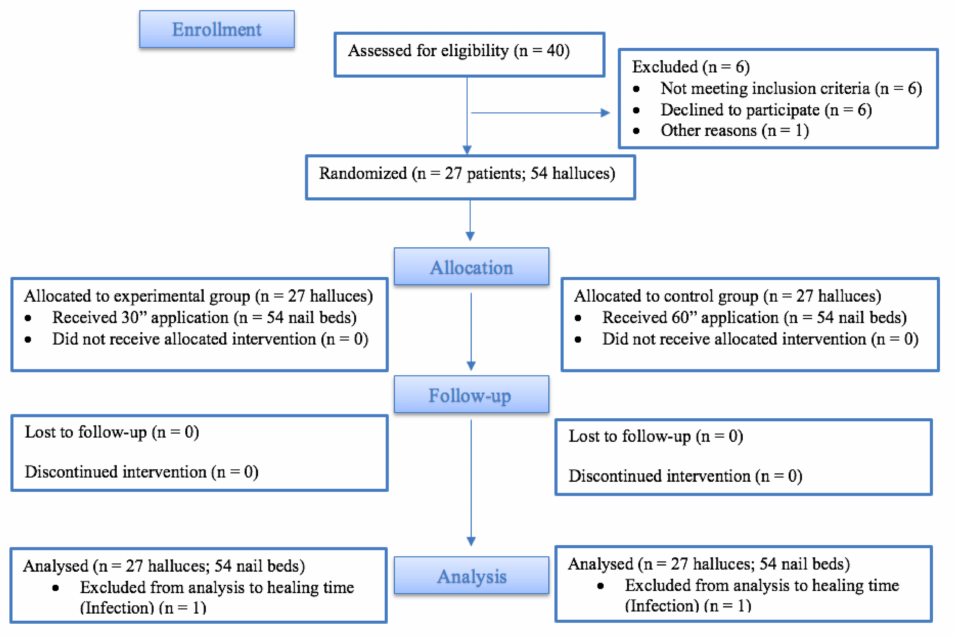
Figure 1. CONSORT flow diagram.